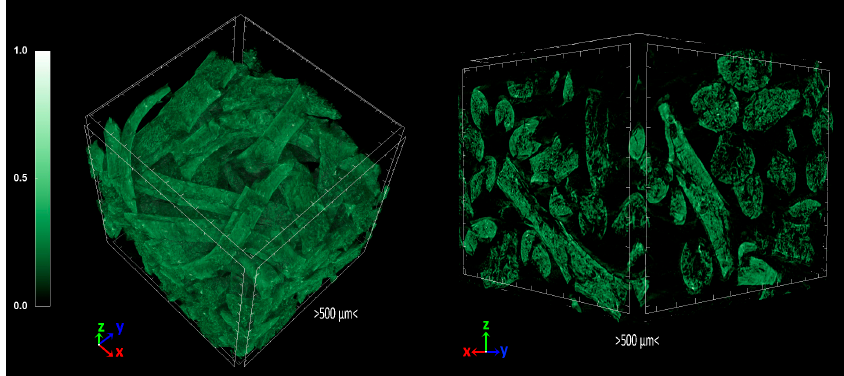
Figure 11. 3D volume rendering of the scanned carbon fibers.